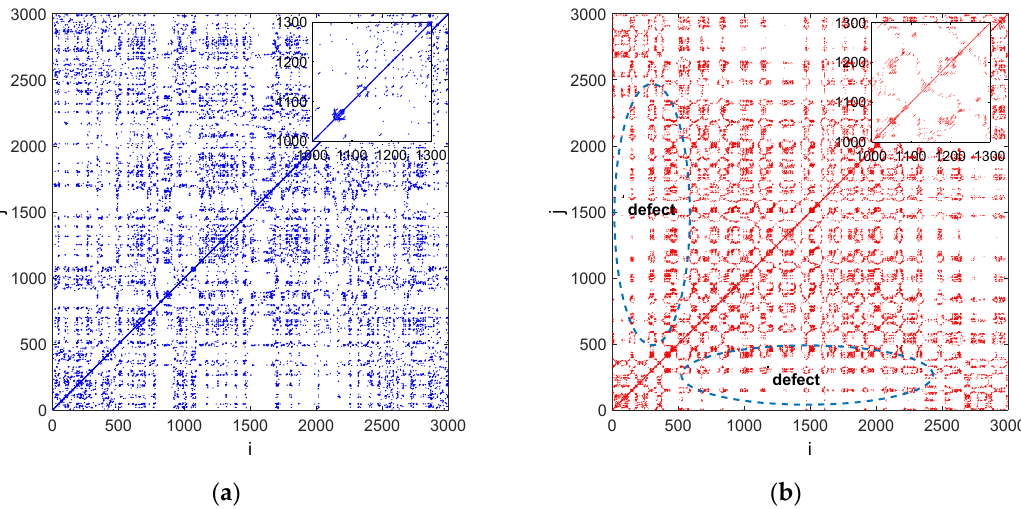
Figure 9. Recurrence plots showing the cutting force in drilling GFRP without defect ( a ) and with defect ( b ). The calculations were made for constant ε = 0.5.